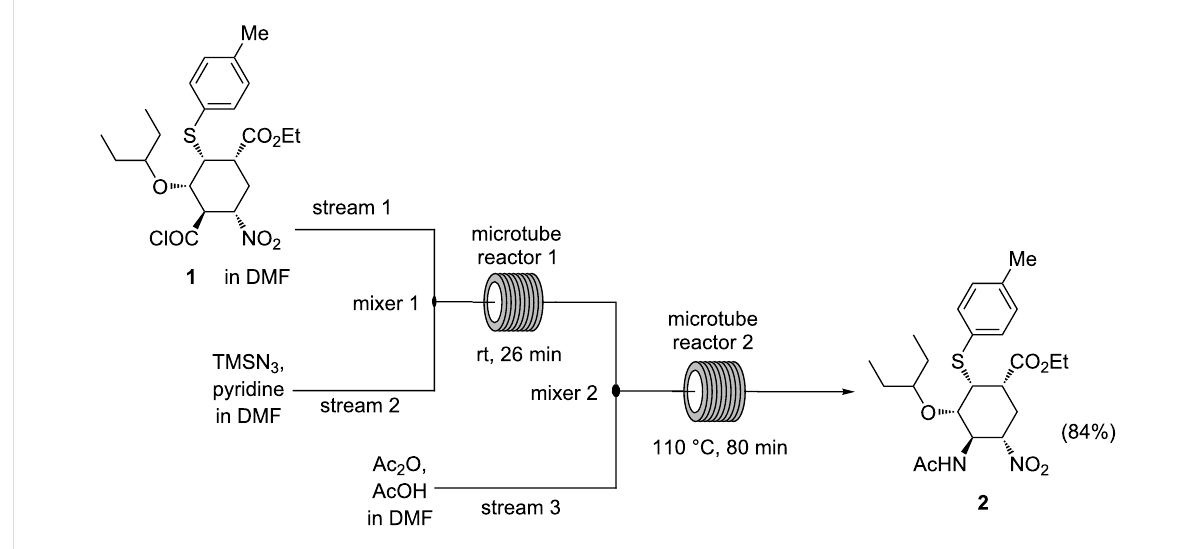
Figure 1: Synthesis of compound 2 from acyl chloride 1 via Curtius rearrangement using a continuous-flow system [14].